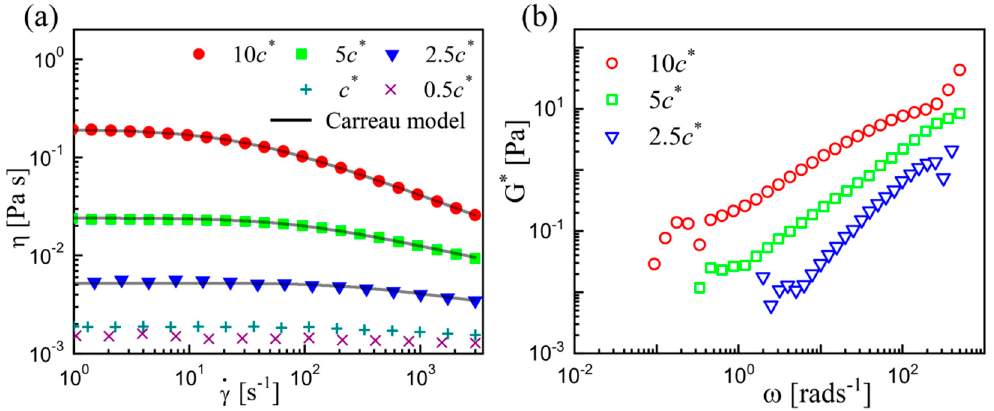
Figure 1. Rheological characterization of PEO solutions. ( a ) The measured viscosities η as a function of shear rate (cid:2011)(cid:4662) at different concentrations. The solid curves at c > c * are fitted by the modified Carreau model. The overlap concentration is c * = 1000 ppm. ( b ) The measured complex moduli at different concentrations.